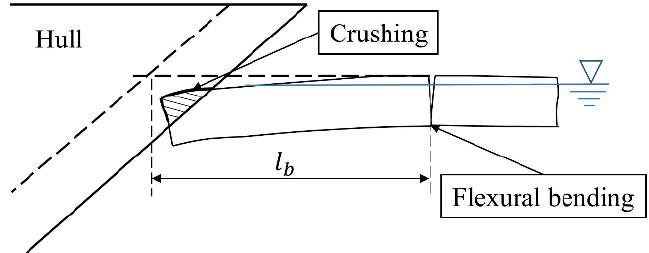
Figure 2. Illustration of the ice breaking model between a ship bow and level ice.